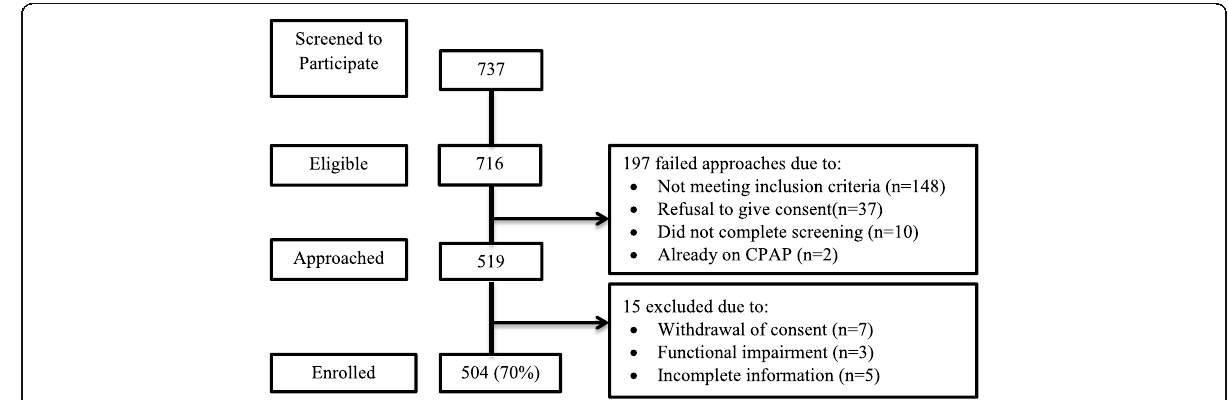
Fig. 1 Flowchart of the screened